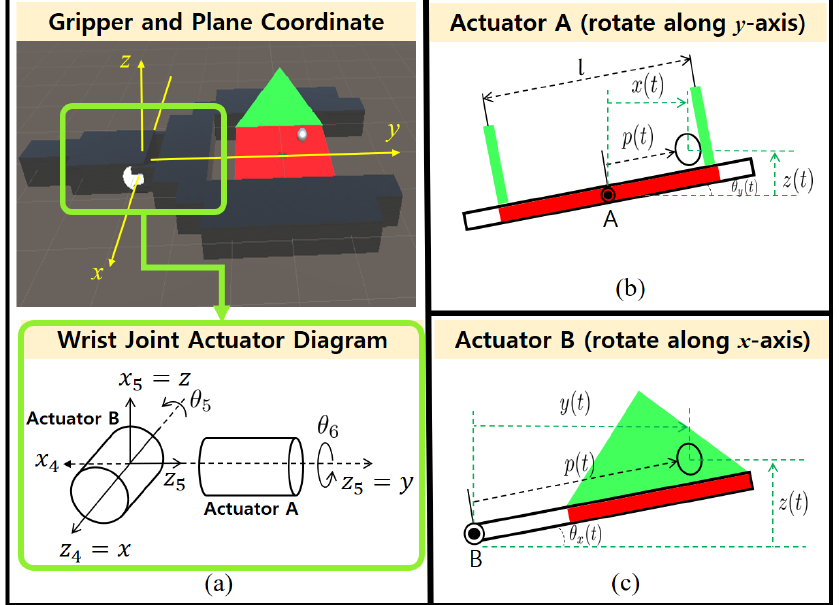
Figure 2. Coordinate setting: ( a ) the robotic gripper and plane coordinate and wrist joint actuators, ( b ) actuator A and corresponding iron ball action along y -axis, and ( c ) actuator B and corresponding iron ball action along x